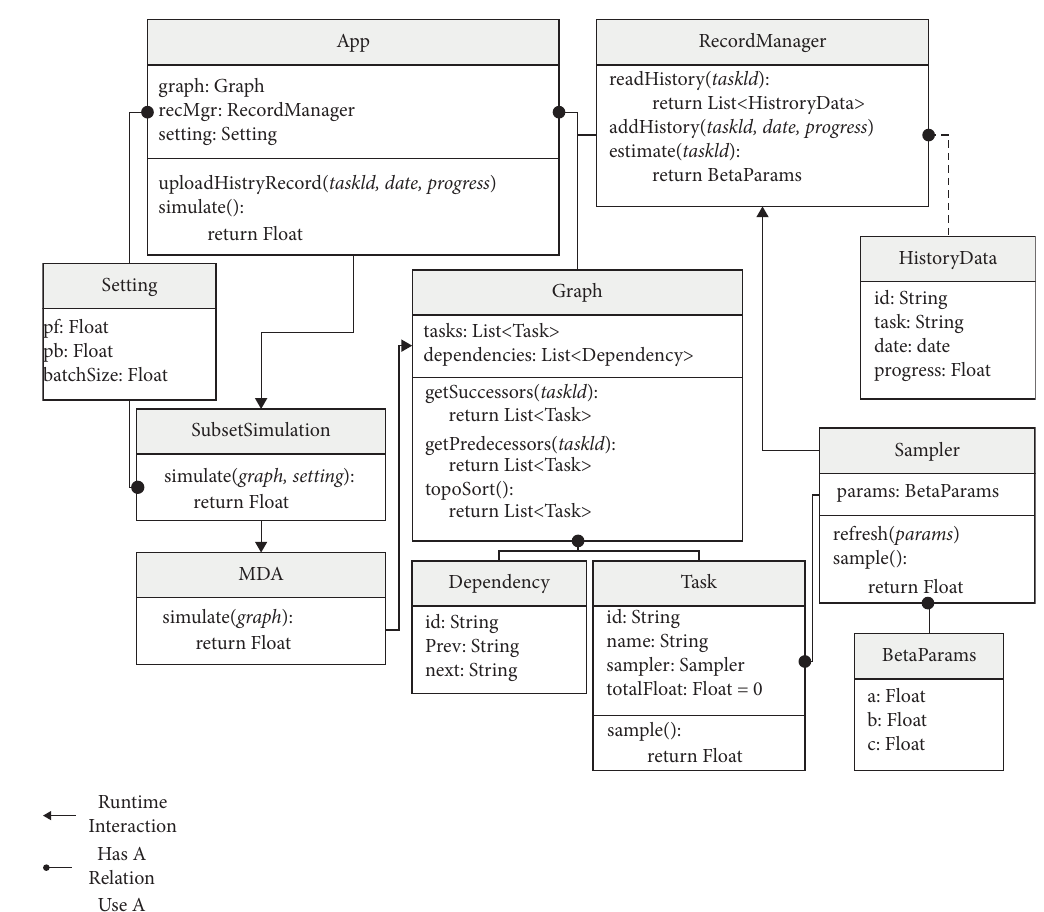
Figure 4: UML class diagram of simulation